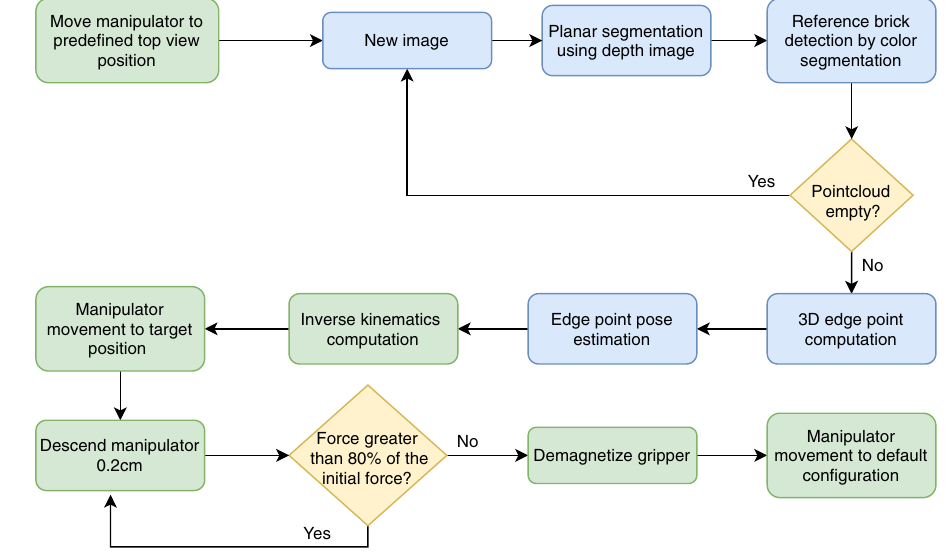
Fig. 13 Flowchart describing the brick placement algorithm Move manipulator to